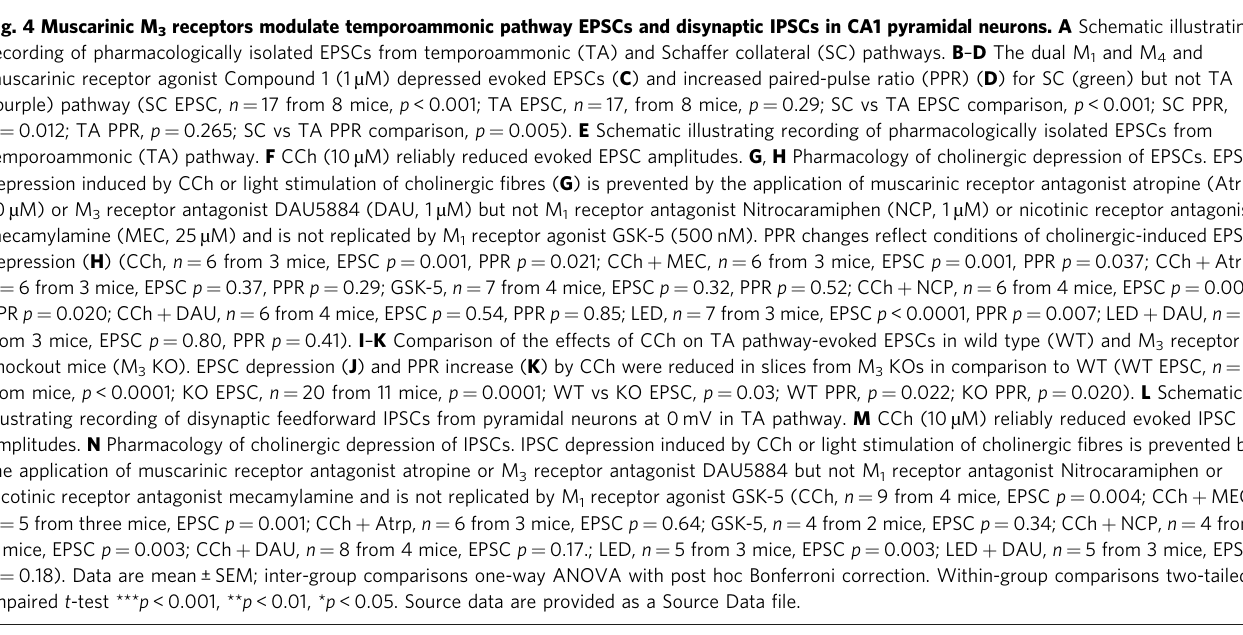
illustrating recording of disynaptic feedforward IPSCs from pyramidal neurons at 0 mV in TA pathway. M CCh (10 µ M) reliably reduced evoked IPSC amplitudes. N Pharmacology of cholinergic depression of IPSCs. IPSC depression induced by CCh or light stimulation of cholinergic fi bres is prevented by the application of muscarinic receptor antagonist atropine or M 3 receptor antagonist DAU5884 but not M 1 receptor antagonist Nitrocaramiphen or nicotinic receptor antagonist mecamylamine and is not replicated by M 1 receptor agonist GSK-5 (CCh, n = 9 from 4 mice, EPSC p = 0.004; CCh + MEC, n = 5 from three mice, EPSC p = 0.001; CCh + Atrp, n = 6 from 3 mice, EPSC p = 0.64; GSK-5, n = 4 from 2 mice, EPSC p = 0.34; CCh + NCP, n = 4